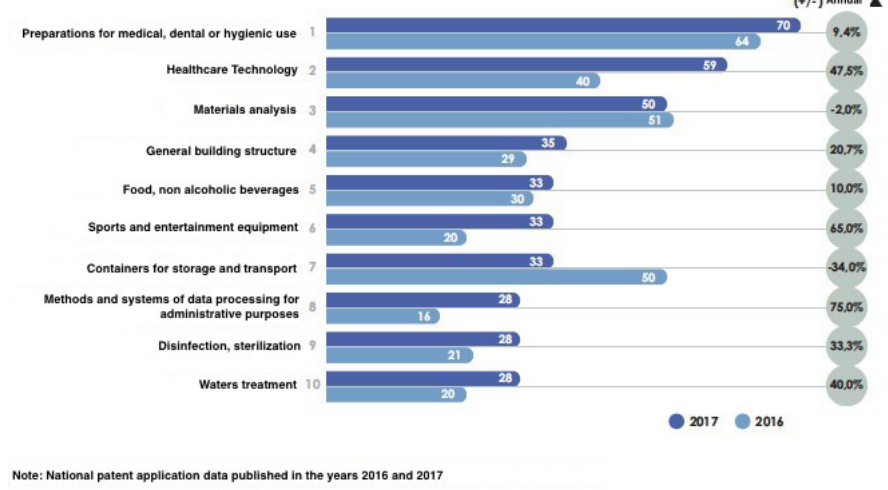
Figure 3. Number of published Spanish patents classified according to their area of